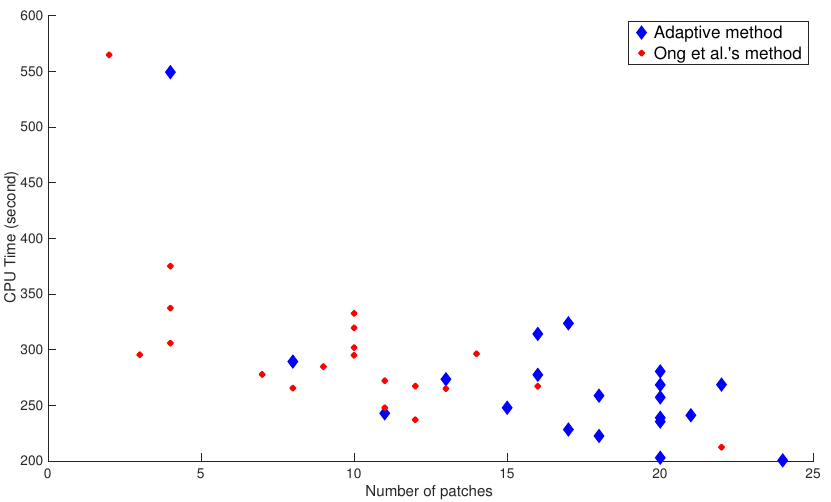
Figure 5. The graph of CPU time against number of